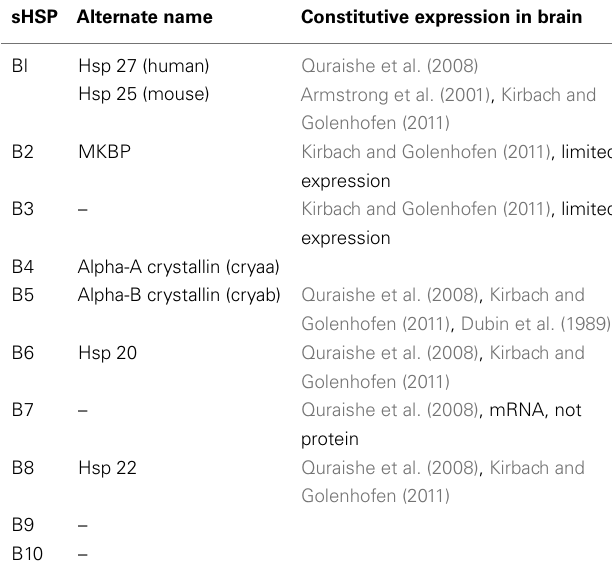
Table 1 | Endogenous expression of sHSPs in the